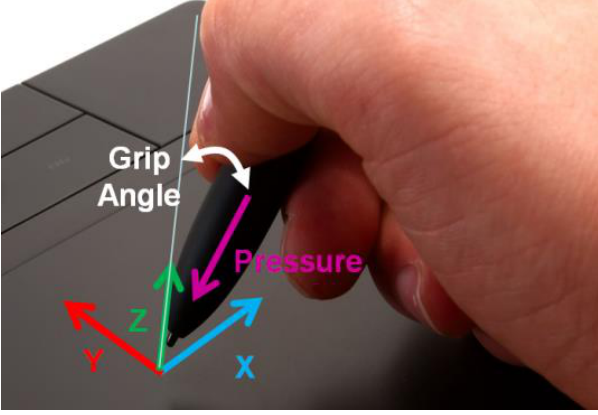
Figure 1. Recorded information: x-y-z coordinates, pressure, and grip